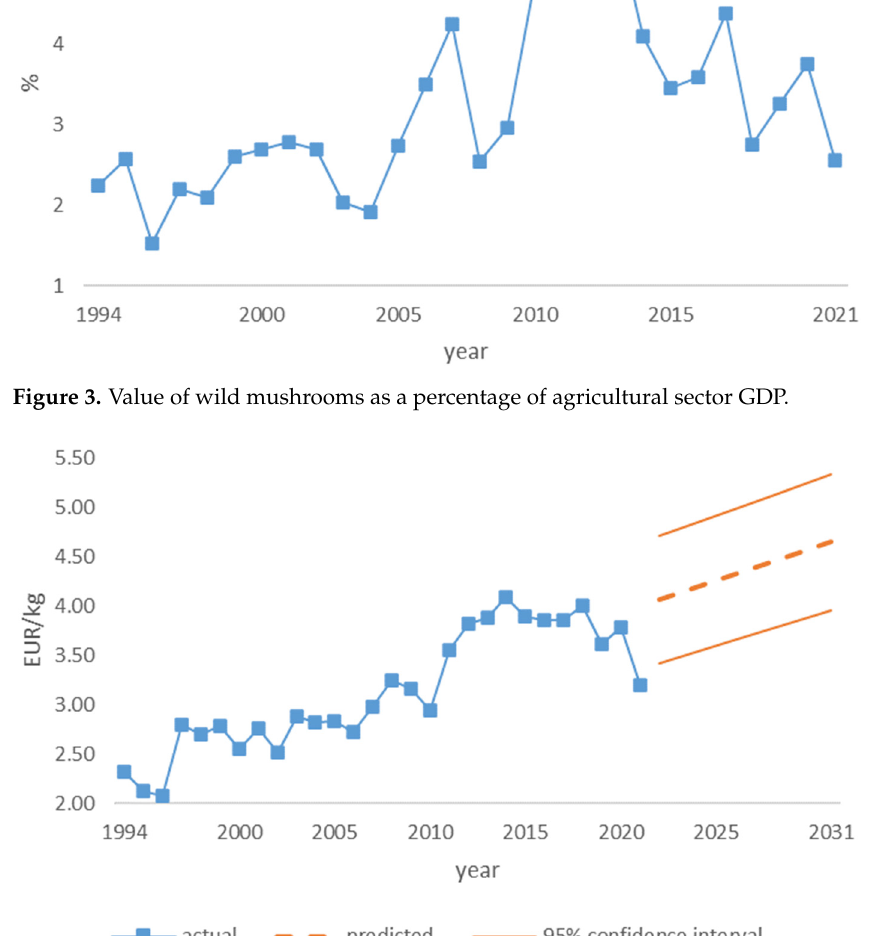
Figure 3. Value of wild mushrooms as a percentage of agricultural sector GDP.